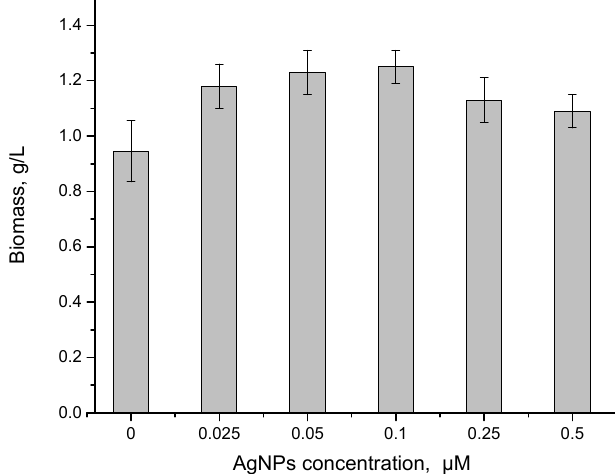
Figure 3. Spirulina platensis biomass at introduction of AgNPs in cultivation medium in concentration range 0.025–0.1 µM .